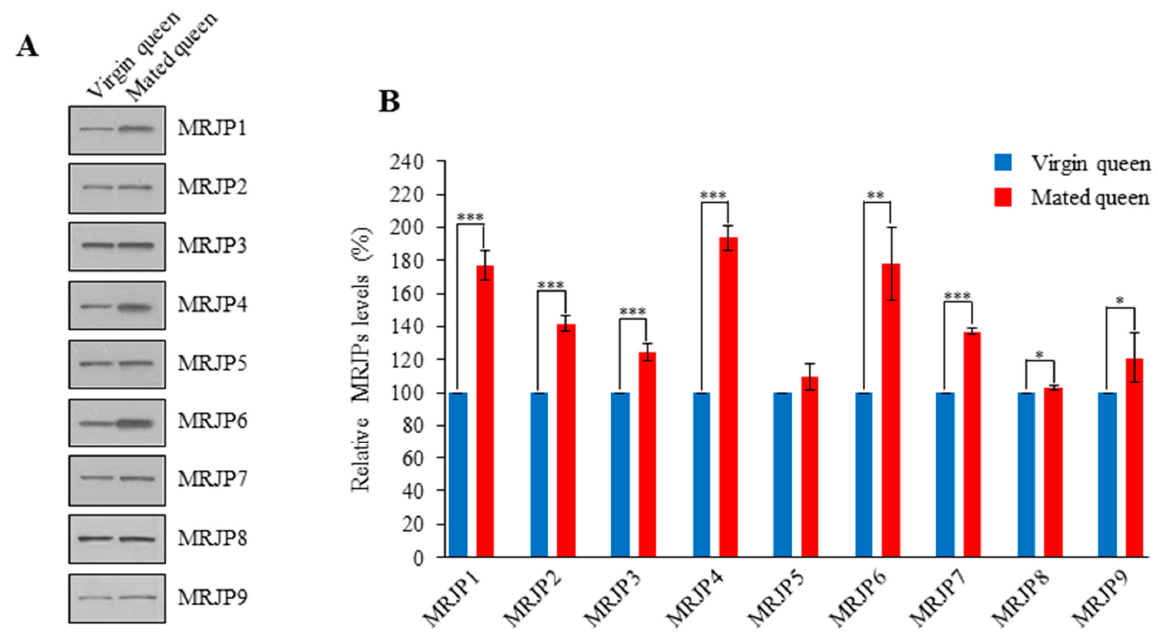
Figure 7. Transcript levels of MRJP genes in the spermathecae of virgin and mated queens. ( A ) The transcripts of MRJP genes ( MRJPs 1-9 ) in the spermathecae of virgin and mated queens were quantitated using RT-PCR. β -actin was used as an internal control. ( B ) The MRJP mRNA levels are shown relative to their levels in the virgin queen’s spermathecae (shown as 100%). The bars represent the mean ± SD values. * p < 0.05, ** p < 0.01, and *** p < 0.001.